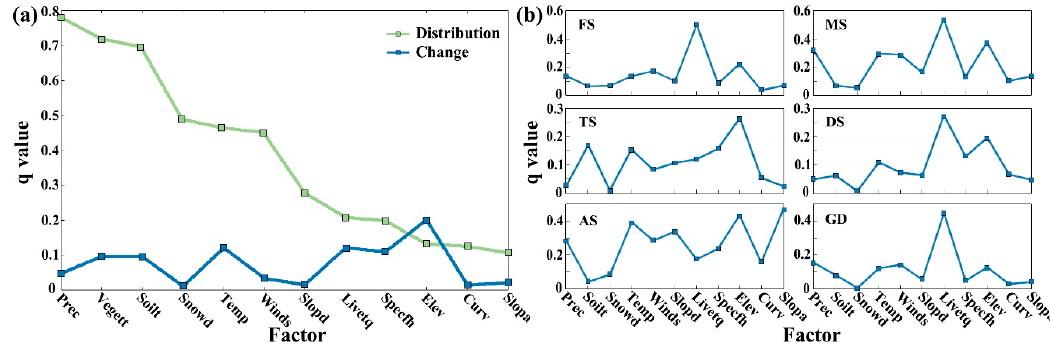
Figure 7. Variations of q values for environmental factors on NDVI distribution and changes: ( a ) Variations of q values for environmental factors on NDVI distribution and change in Mongolia as a whole, and ( b ) variations in the q values of environmental factors on NDVI distribution for different vegetation types. The full name of all abbreviations are as following: Precipitation (Prec), Vegetation type (Vegett), Soil type (Soilt), Snow depth (Snowd), Temperature (Temp) > Wind speed (Winds), Slope degree (Slopd), Livestock quantity (Livstq), Specific humidity (Specfh), Elevation (Elev), Curve (Curv), Slope aspect (Slopa), Forest (FS), Meadow steppe (MS), Typical steppe (TS), Desert steppe (DS), Alpine steppe (AS), Gobi Desert (GD).